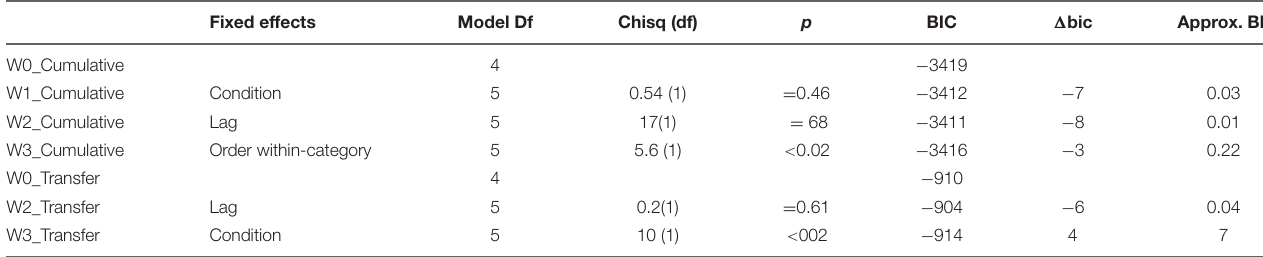
TABLE 4 | The fit indices on the analysis for word